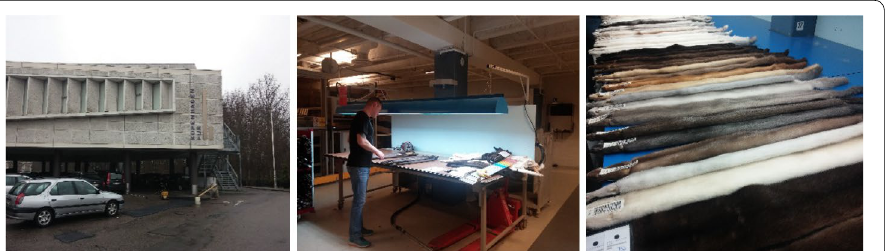
Fig. 9 KF auction house, photographed by the